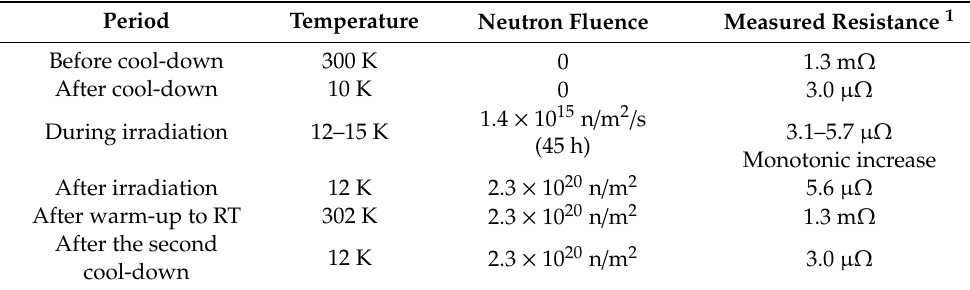
Table 2. Summary of the resistance changes observed during the experiment. Period